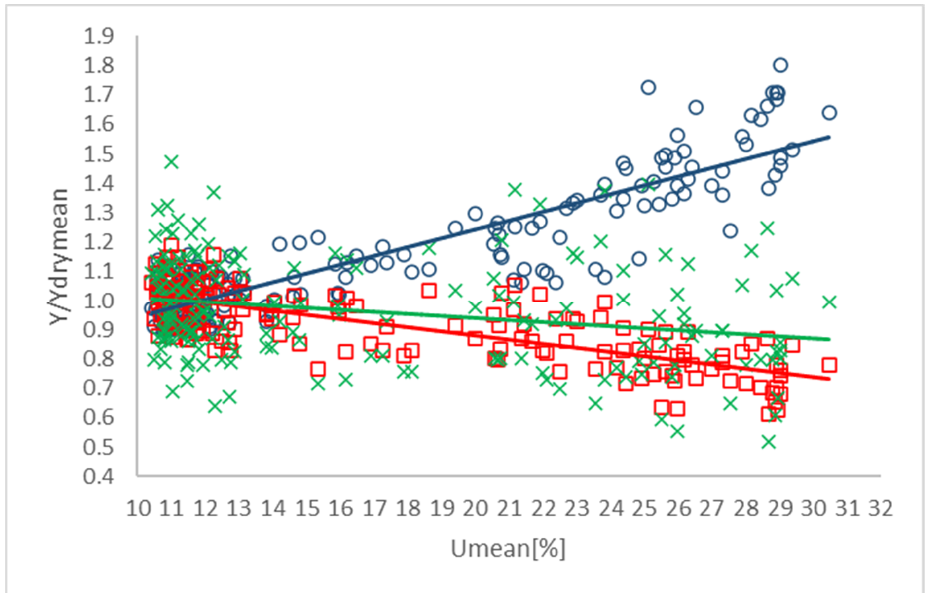
Figure 11. Ratio between feature (ρ, V, MoE dyn ) and mean feature measured in dry conditions (ρ dry,mean , V dry,mean , Mo Edry,mean ) vs. moisture content U. ○ is ρ / ρ dry,mean ; □ is V/V dry,mean ; × is MoE dyn /MoE dry,mean .